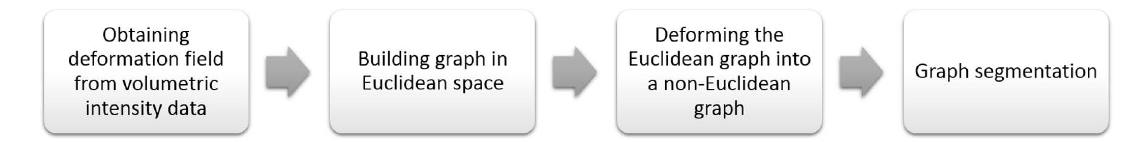
Figure 2. Non-Euclidean graph search proceeds in four steps.